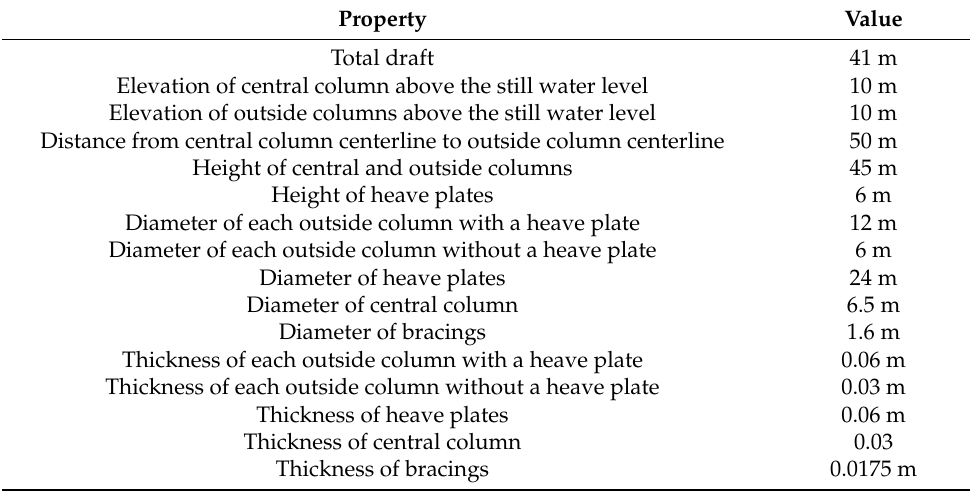
Figure 3. View of the fishing cage with key dimensions (without nets). ( a ) ISO view; ( b ) Top view; ( c ) Side view. Table 1. Geometric properties of the fishing cage.